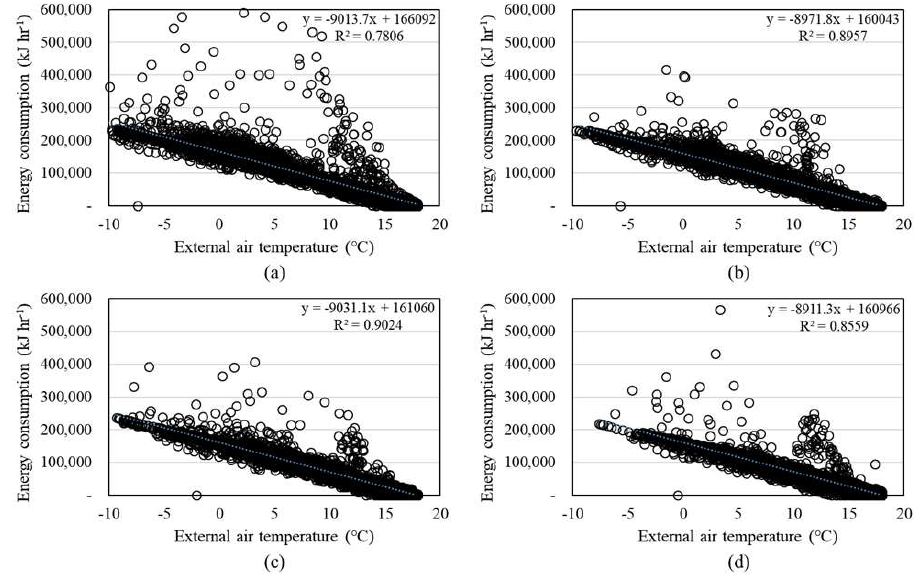
Figure 19. Changes in the heating energy load of BiRTG by region and according to external air temperature in ( a ) Seoul, ( b ) Daejeon, ( c ) Daegu, and ( d ) Pusan.